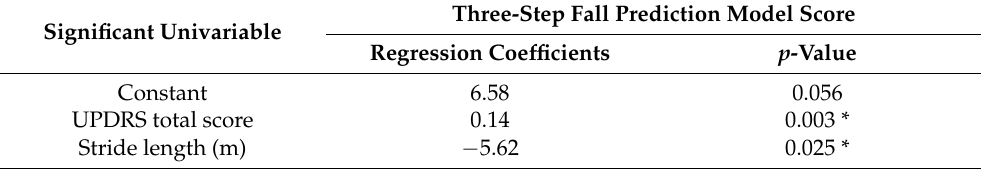
Table 6. Effects of the variables on the three-step fall prediction model score in multiple linear regression according to a correlation analysis.